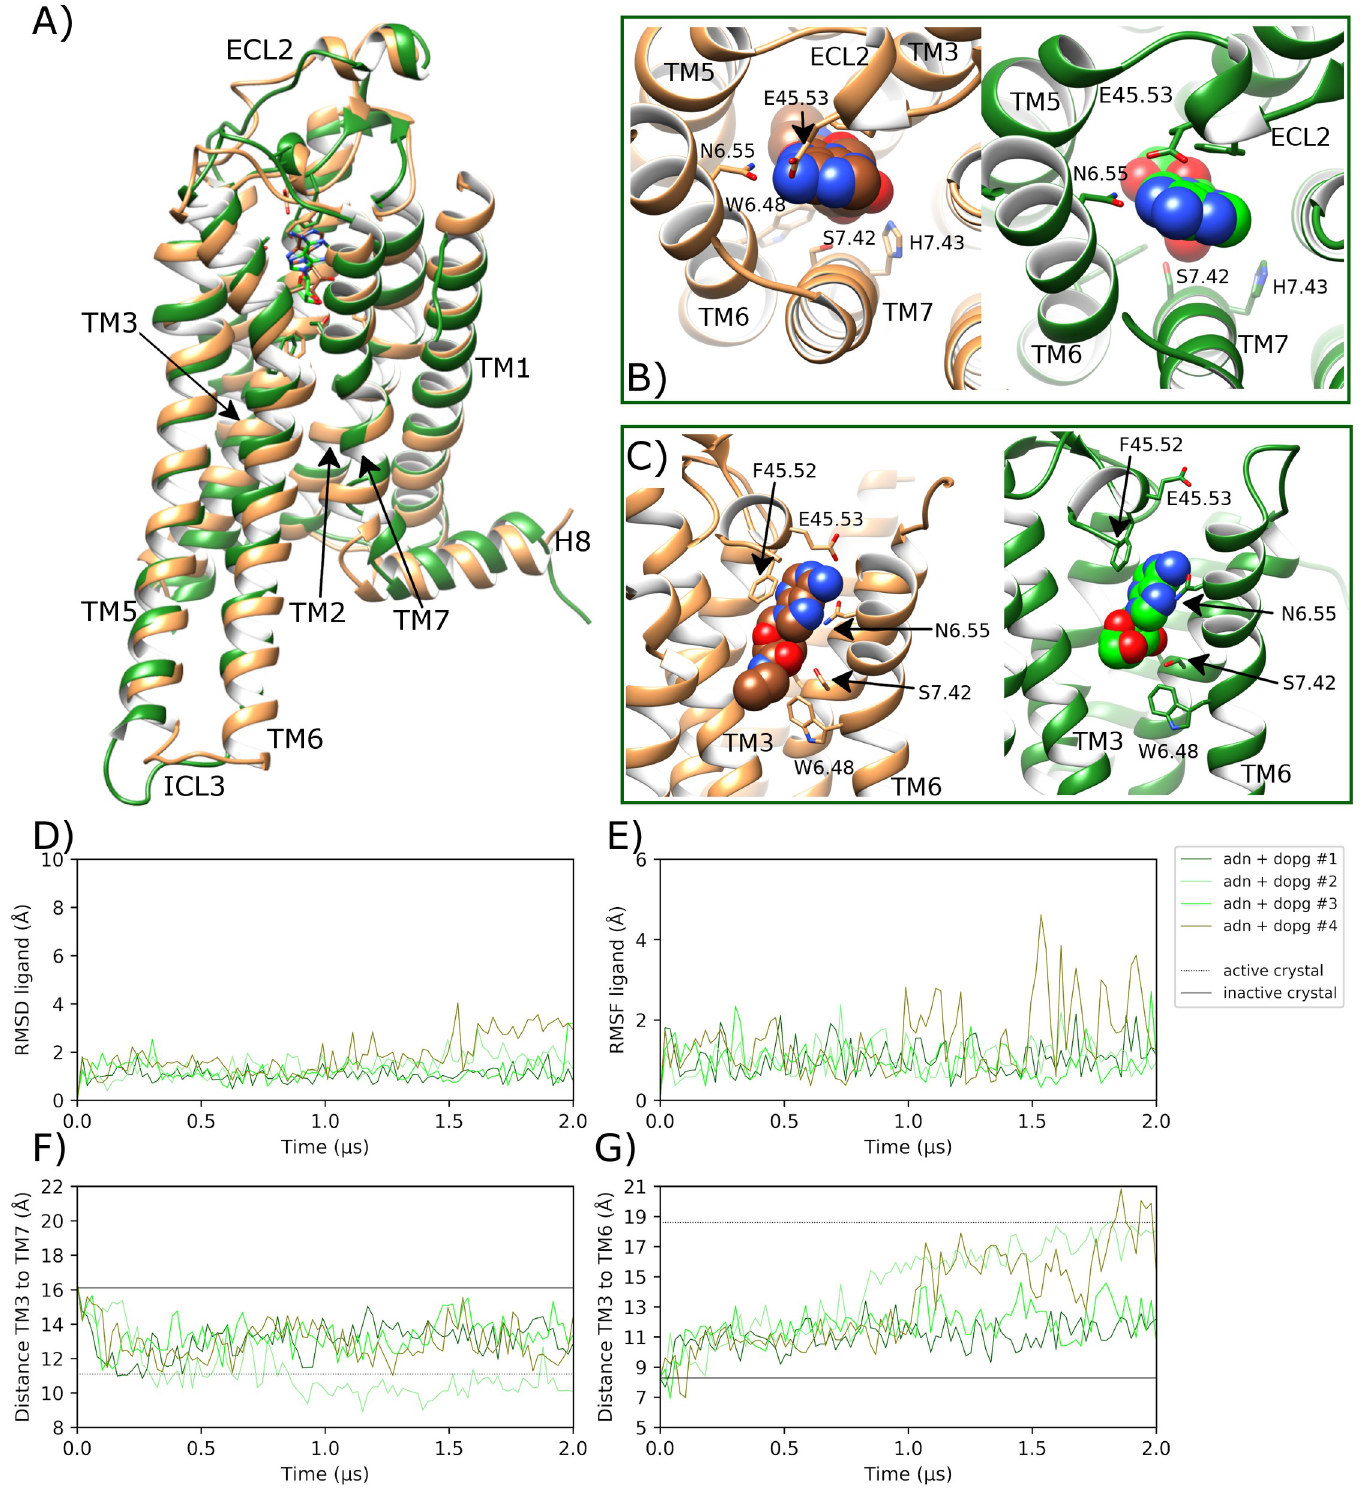
Fig 8. Transition towards an active-like state of A2aR in MD simulations with bound adenosine in a DOPG membrane. A) Comparison of the MD-generated conformation of A2aR bound to adenosine (ADN) within a DOPG membrane (green, belonging to replica #2 from 0.7 μ s) with the active crystal structure of A2aR with bound NECA (brown, PDB entry: 6GDG), showing B) and C) protein-agonist interactions in the orthosteric pocket with adenosine and NECA atoms displayed as